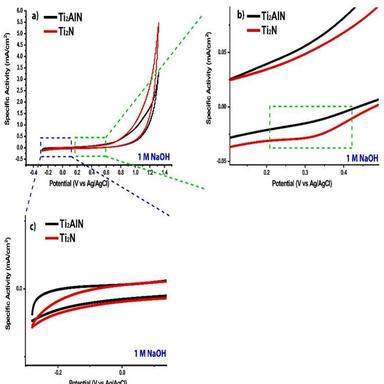
CVs of Ti2AlN/GCE, Ti2NTx/GCE and GCE in a) 1 M NaOH and b) 1 M NaOH+0.02 M N2H4.